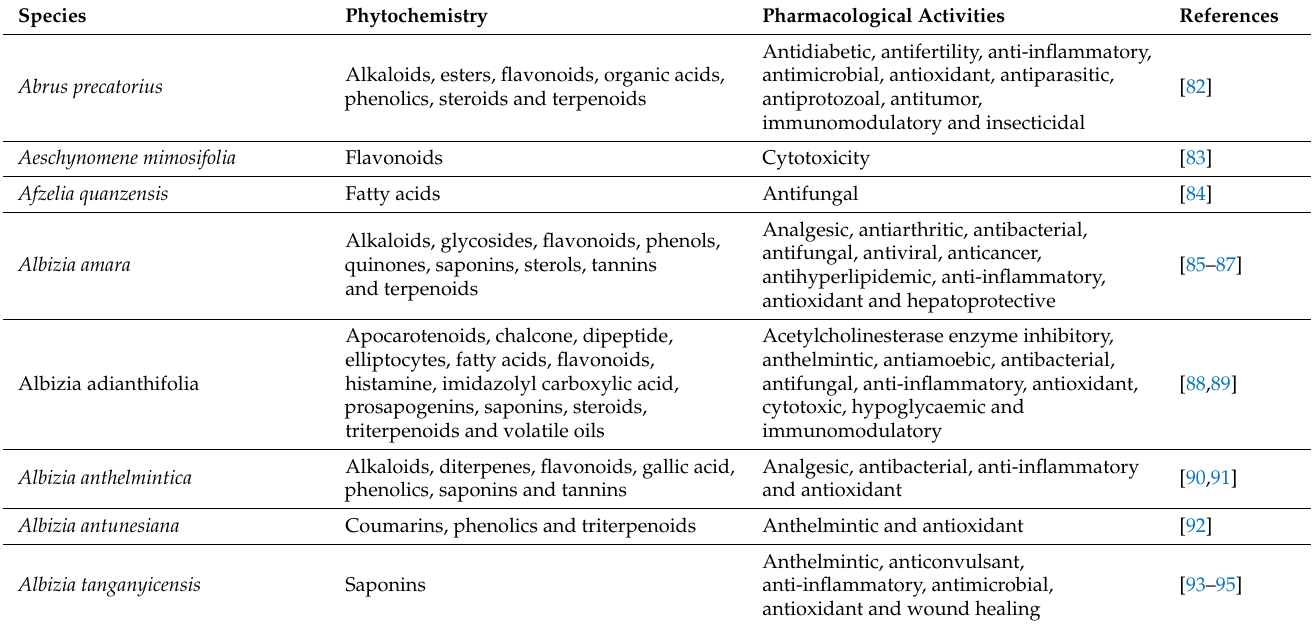
Table 3. Phytochemistry and pharmacological properties of Fabaceae species used as traditional medicines in Zimbabwe.